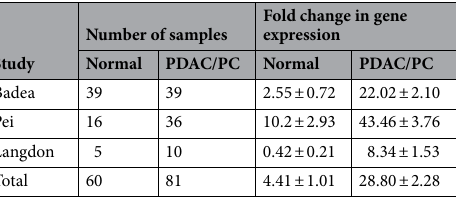
Table 1. Activin A gene expression is upregulated in pancreatic ductal adenocarcinoma (PDAC) or pancreatic cancer (PC).